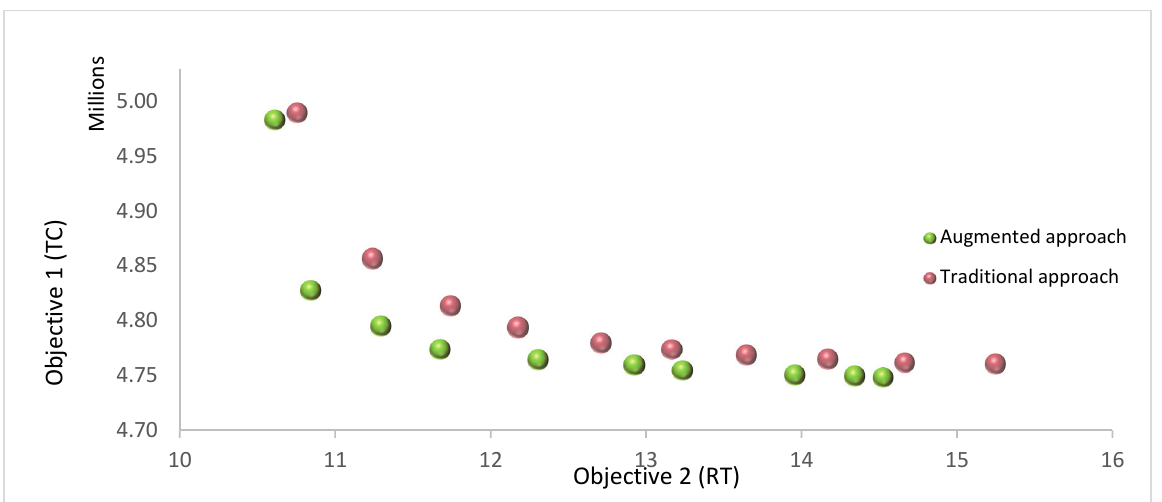
Fig. 9. Comparison between Pareto points obtained via the augmented and traditional